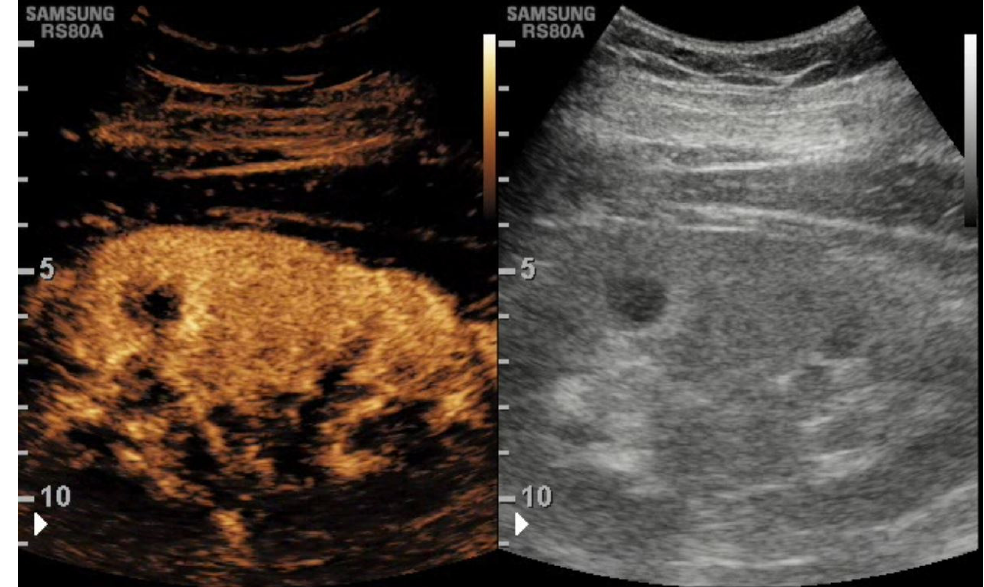
Figure 1. At CEUS, the hypertrophic pseudonodular appearance of the middle renal cortex shows the same appearance of the remaining cortex, thus confirming it is a hypertrophied column of Bertin. CEUS allows a real ‐ time assessment of contrast enhancement, with the ability to record the entire real ‐ time, high frame rate examination as a cine ‐ loop for review. Real ‐